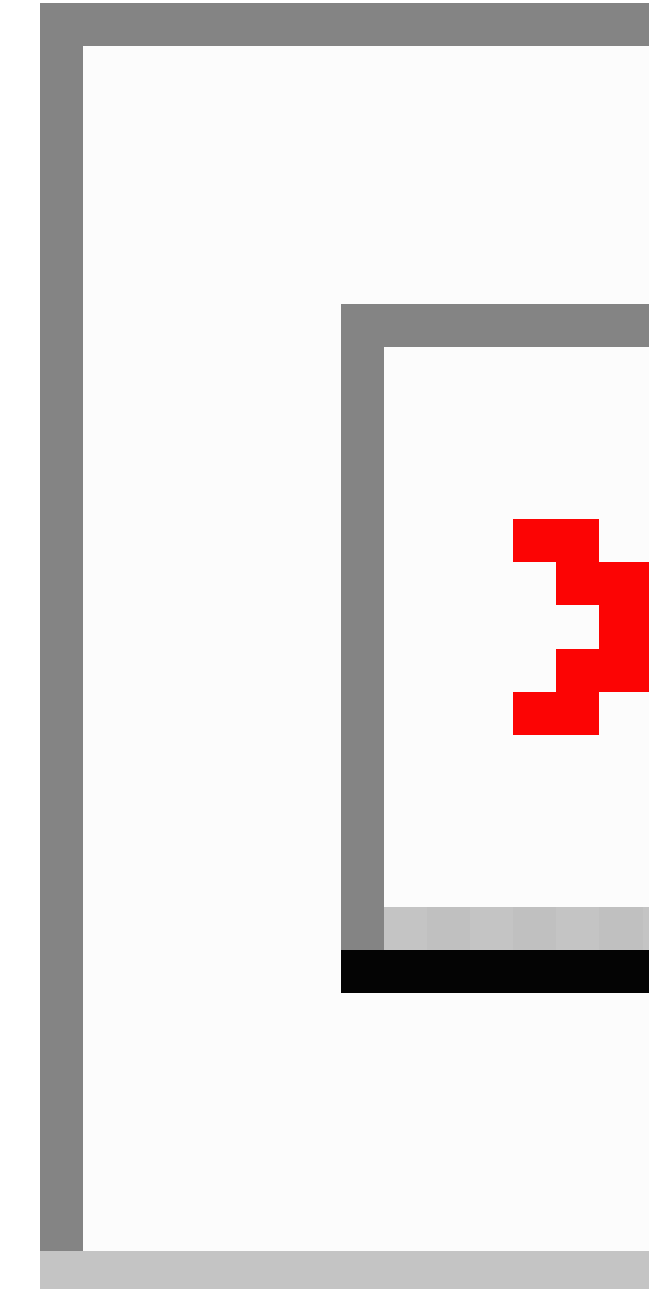
Figure 1. mHealth app intervention development